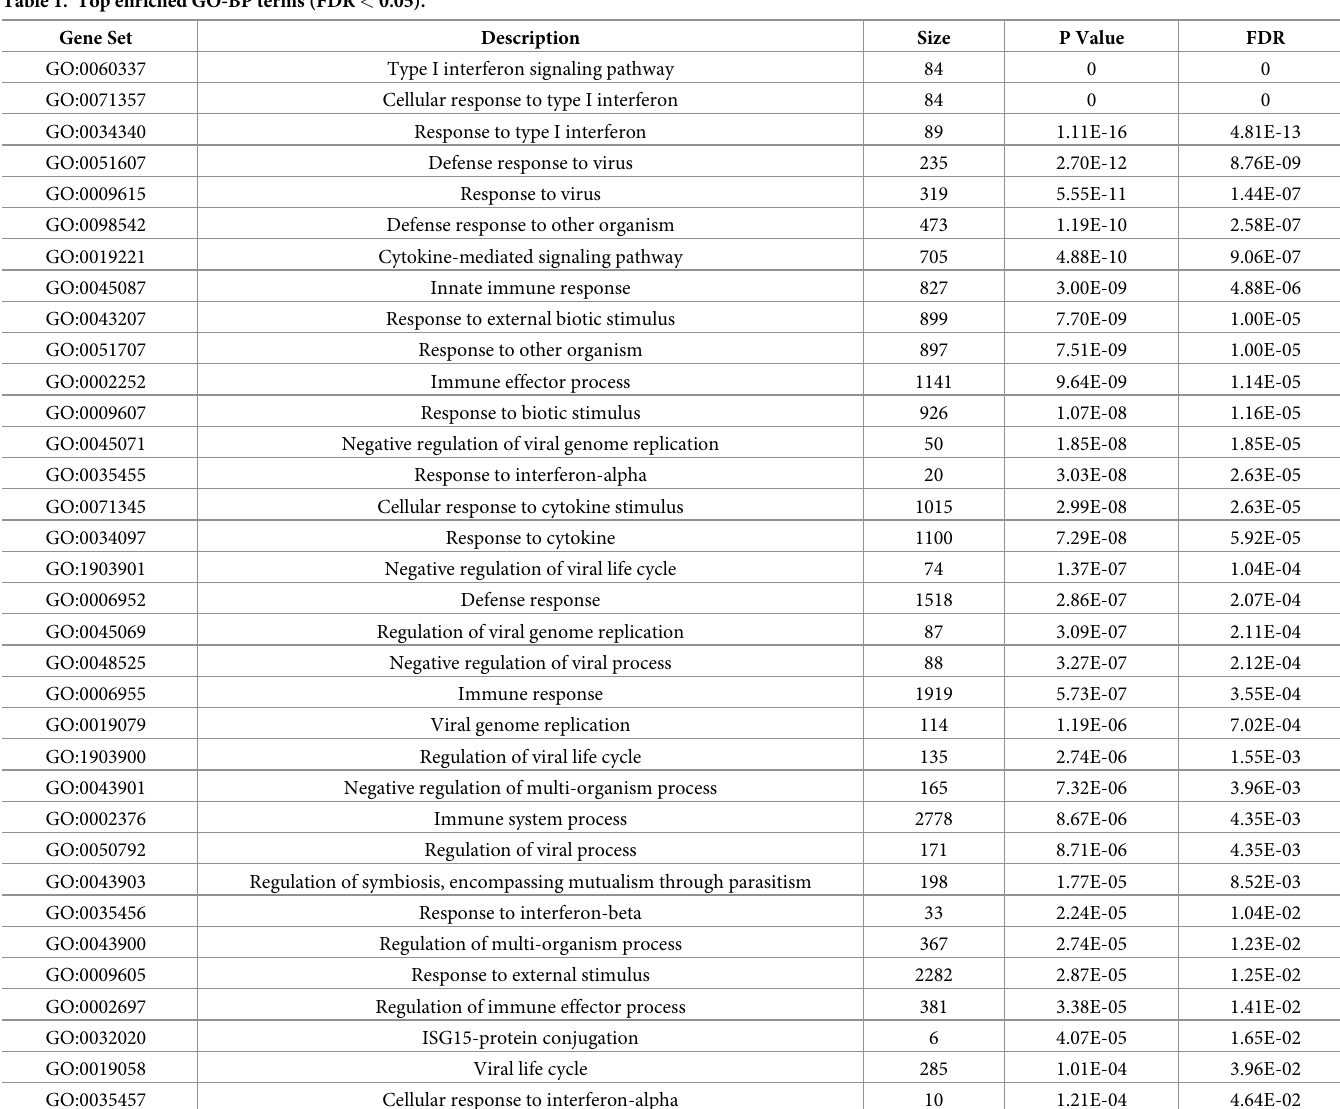
Table 1. Top enriched GO-BP terms (FDR <